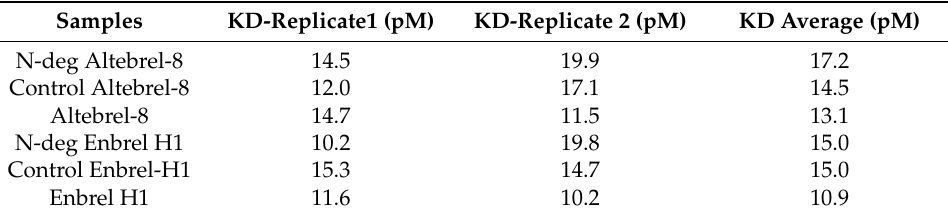
Table 4. KD values of the etanercept samples in